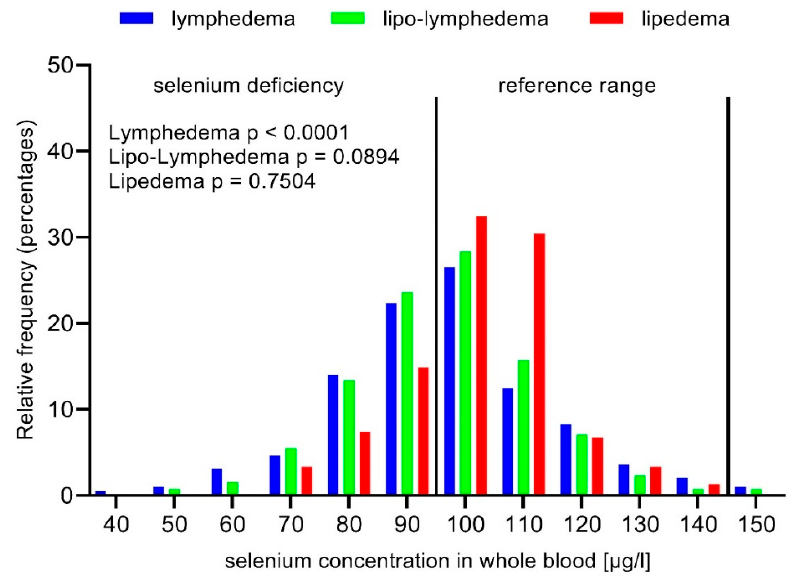
Figure 4. Selenium concentration in whole blood in obese lymphedema, lipo-lymphedema, and lipedema patients (BMI ≥ 30). Table 4. Odds ratio for selenium deficiency in patients with lymphedema, lipo-lymphedema, and lipedema.